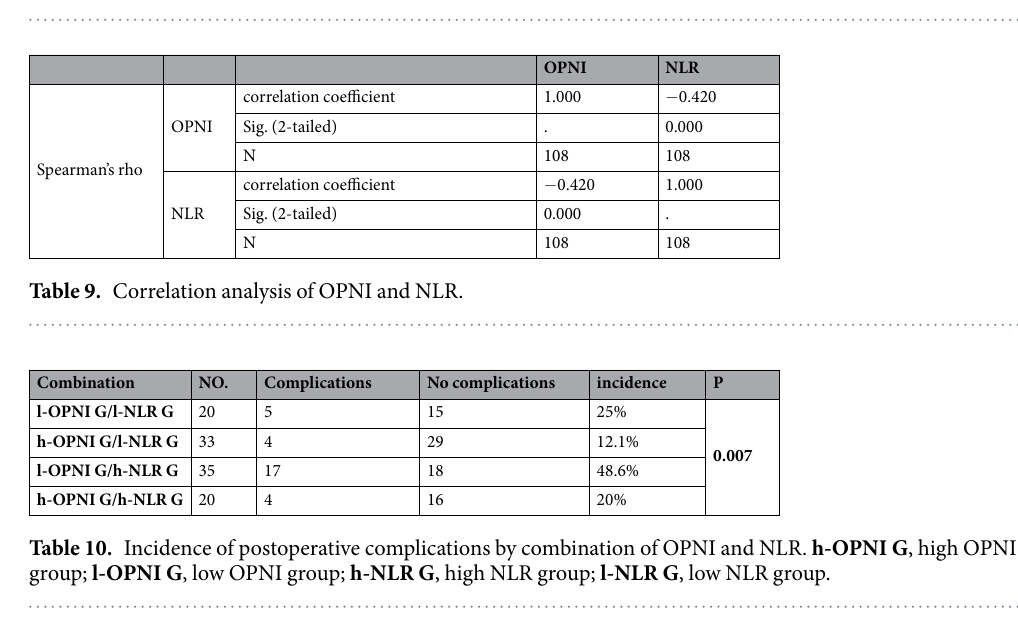
Table 8. Fourfold table of each complication according to the incidence of complications and the level of NLR